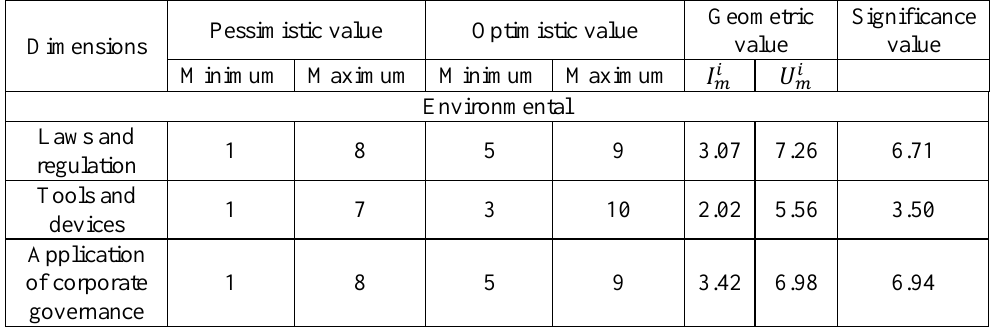
Table 4. Performance indicators based on the Fuzzy Delphi method